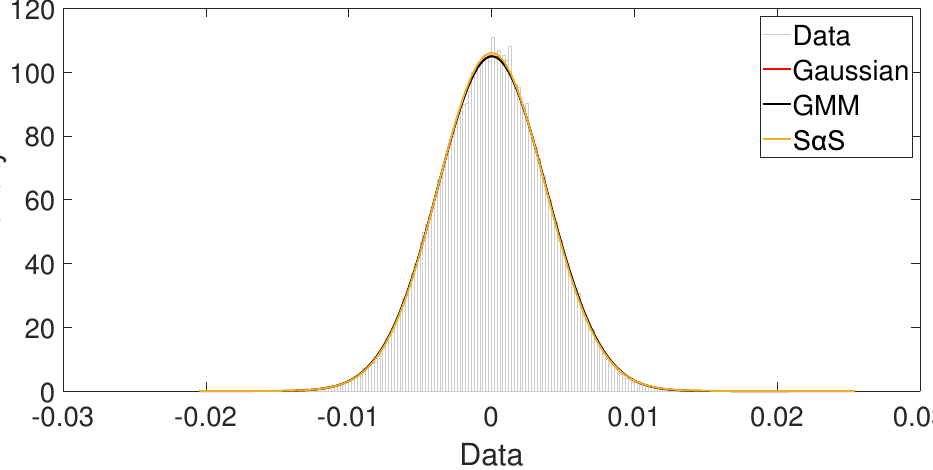
Figure 14. Indoor scenario: Visual comparison among Gaussian, GMM and S α S PDF fitting.